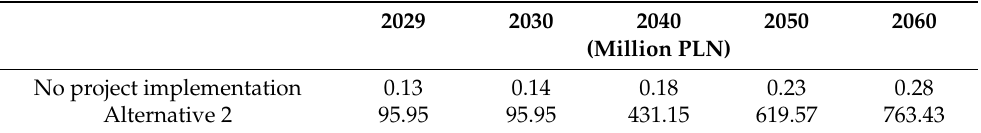
Table 2. Differential revenues from electricity sales for no project implementation and for alternative 2 of the project [45].